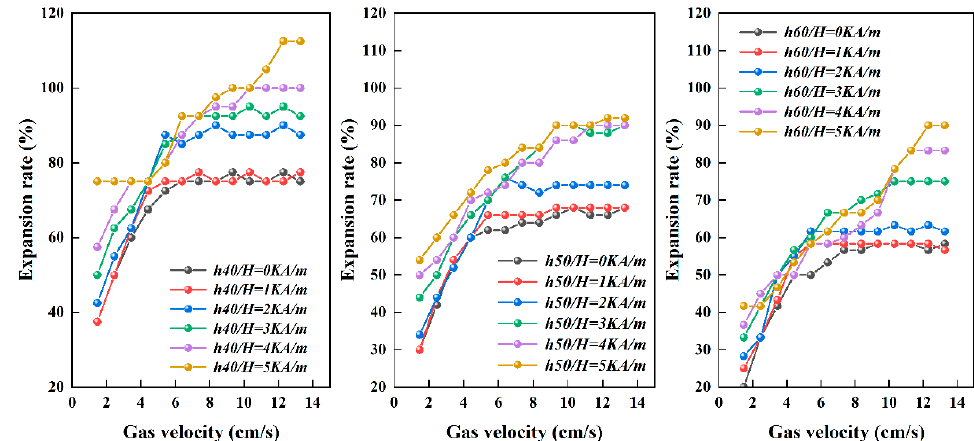
Figure 9. Bed expansion rate at different static bed heights and different magnetic field strengths.